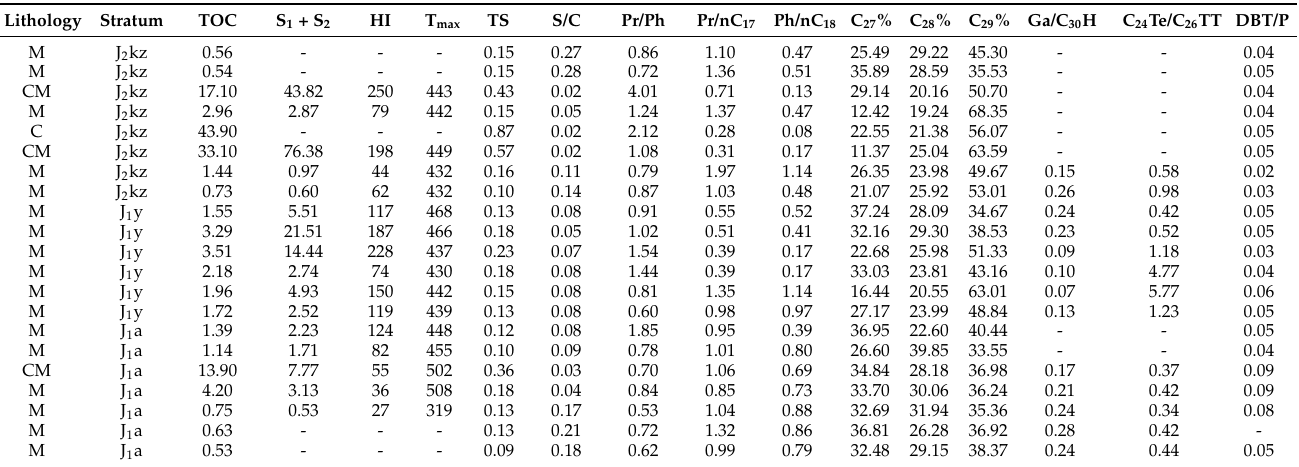
Table 1. Total organic carbon and sulfur contents (wt.%), n -alkane, regular isoprenoid ratios and biomarker parameters of the northern tectonic